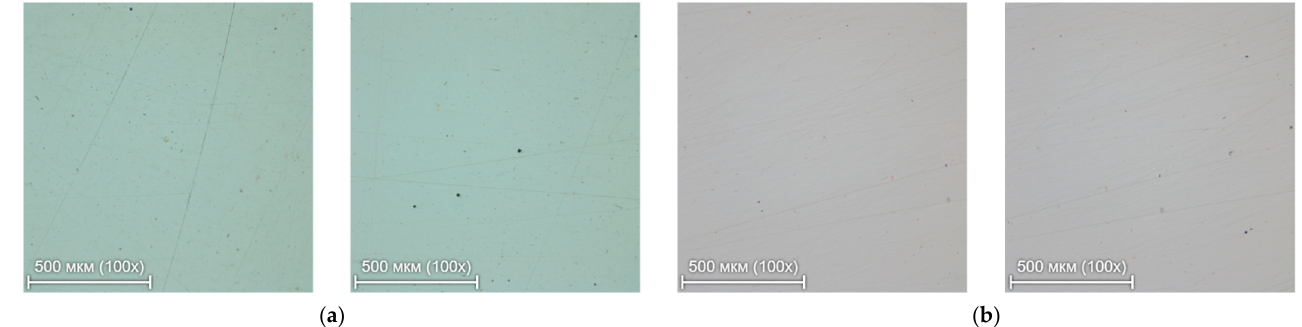
Figure 5. Photographs of the sample 200 W, 900 mm/s: ( a ) the topmost surface taken from different areas; ( b ) lateral surface taken from different areas.